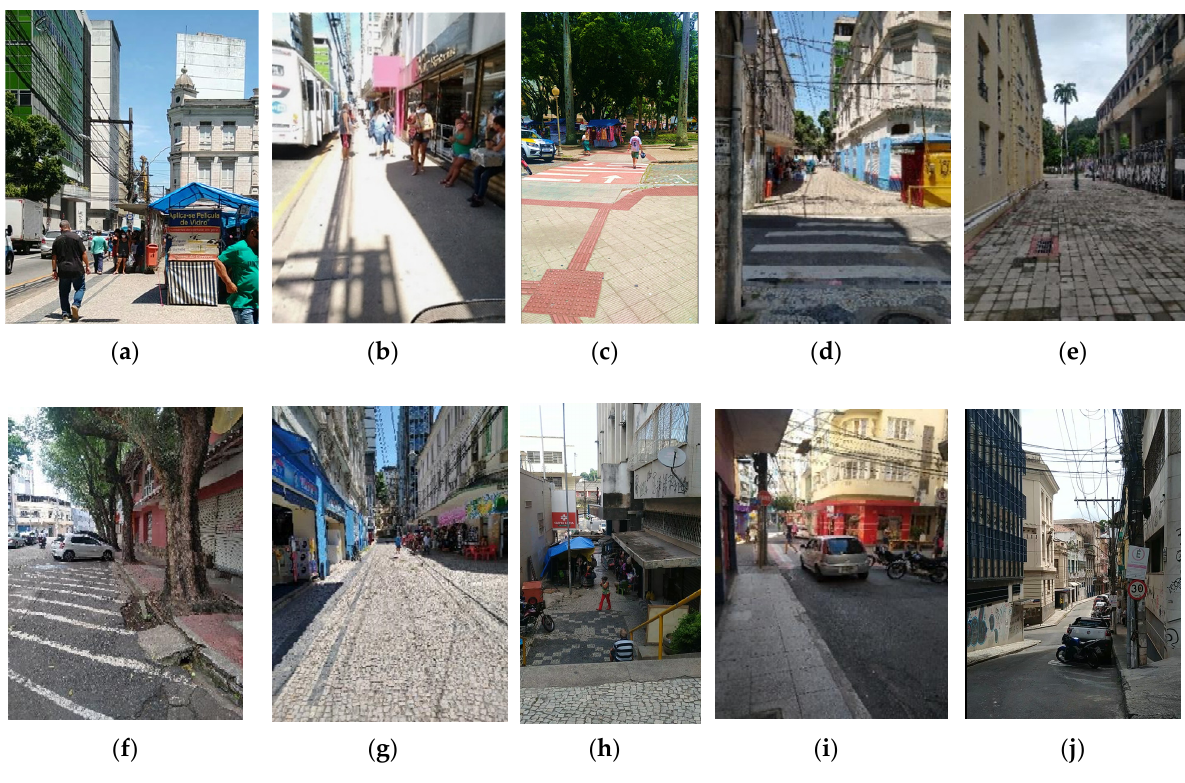
Figure 4. Photos of the study area in Vitória, Brazil, taken between January and March 2021 ( a ) Av. Jerônimo Monteiro; ( b ) Av. Jerônimo Monteiro, showing the absence of benches and people resting against the wall of the store; ( c ) passageway to Praça Costa Pereira; ( d ) passageway in front of R. João Aguirre; ( e ) Rua João Caetano, exclusively for pedestrians; ( f ) a corner of Praça Ubaldo Ramalhete Maia, with slope and crossing issues; ( g ) Rua João Aguirre, exclusively for pedestrians; ( h ) view of Rua Cerqueira Lima, exclusively for pedestrians, with stairway and street commerce in the background; ( i ) raised crosswalk at the intersection of Rua Prof. Baltazar and the pedestrian street Sete de Setembro; ( j ) stretch of Rua Duque de Caxias, with steps and a steep slope. Table 1. Dimensions and related urban variables of the